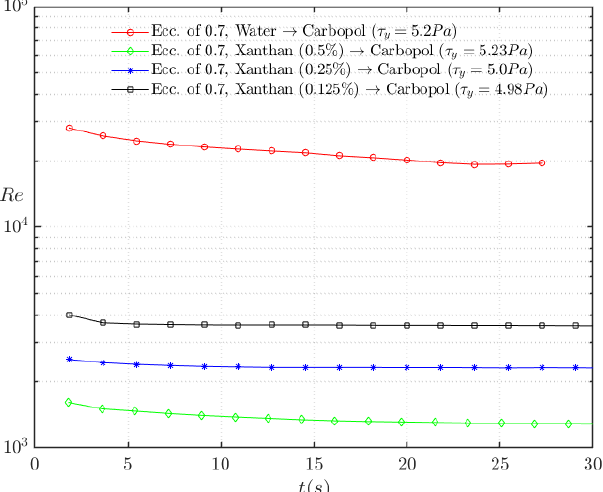
Figure 11. Computed Reynolds number for the displacing fluid in the partially eccentric annulus ( e = 0.7).